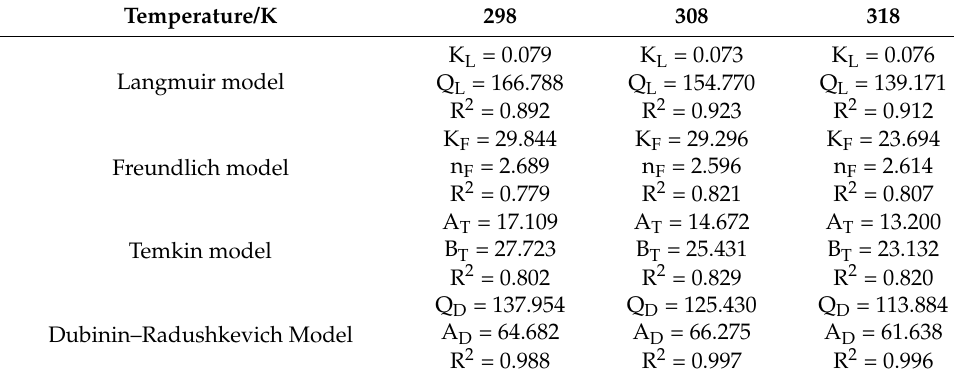
Figure 10. The fittng curves with nonlinear two-parameter adsorption isotherm models: ( a ) 298 K, ( b ) 308 K, and ( c ) 318 K. Table 6. Fitting parameters and correlation coefficients with nonlinear two-parameter adsorption isotherm models at different